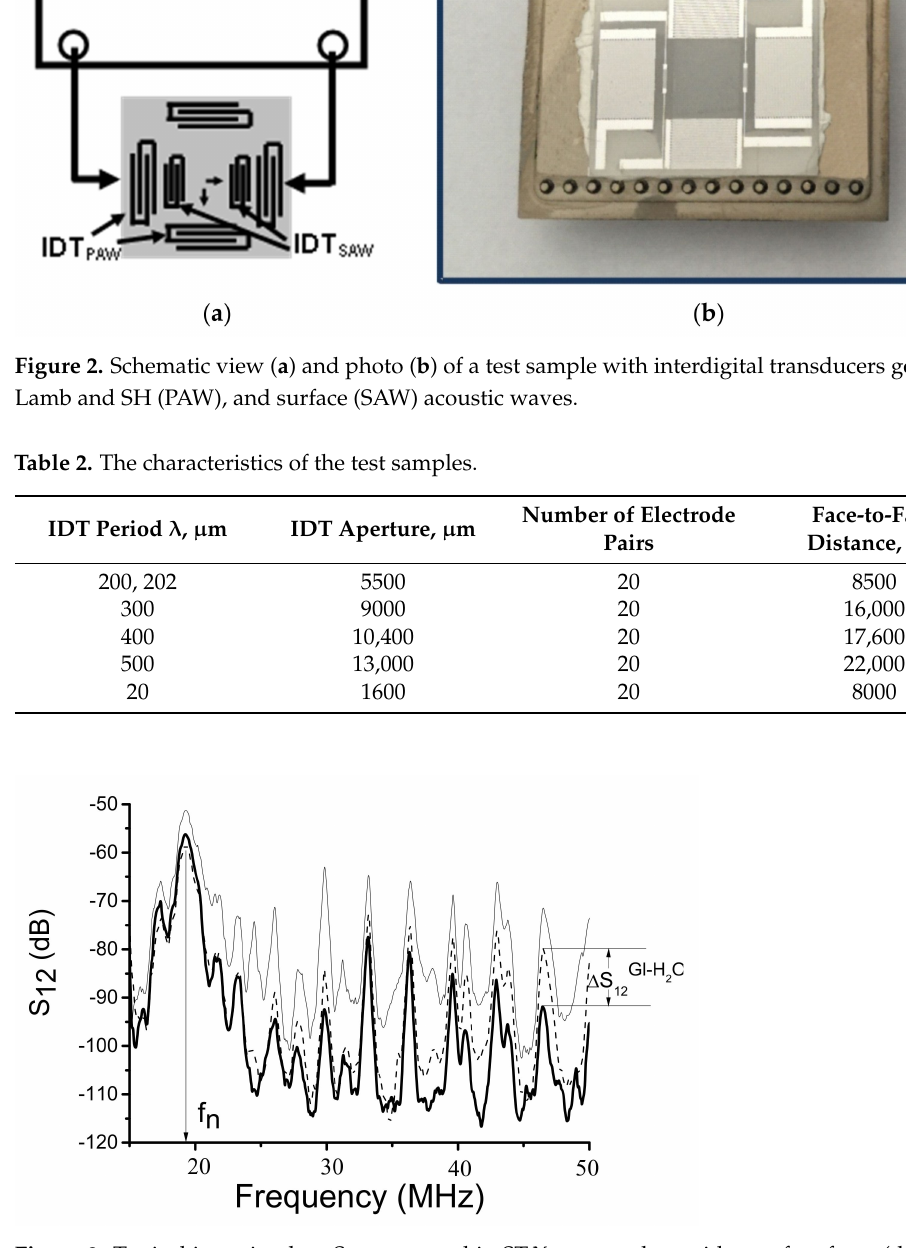
Figure 3. Typical insertion loss S 12 measured in ST,X-quartz plate with two free faces (thin solid), one free face and one water-loaded face (dashed), and one free face and one glycerin-loaded face (thick solid). Plate: h = 500 µ m, IDTs: λ = 300 µ m, h/ λ = 1.67. Liquids are over the propagation path L = 22 mm on the bottom of the